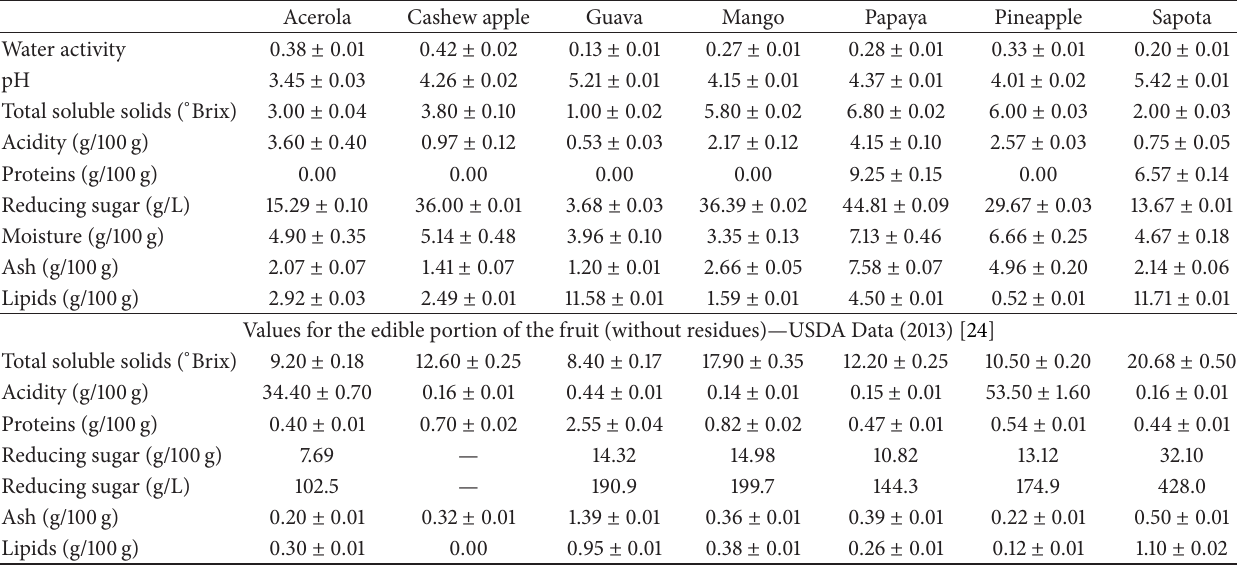
Table 1: Physicochemical properties of tropical fruit residues. Acerola Cashew apple Guava Mango Papaya Pineapple